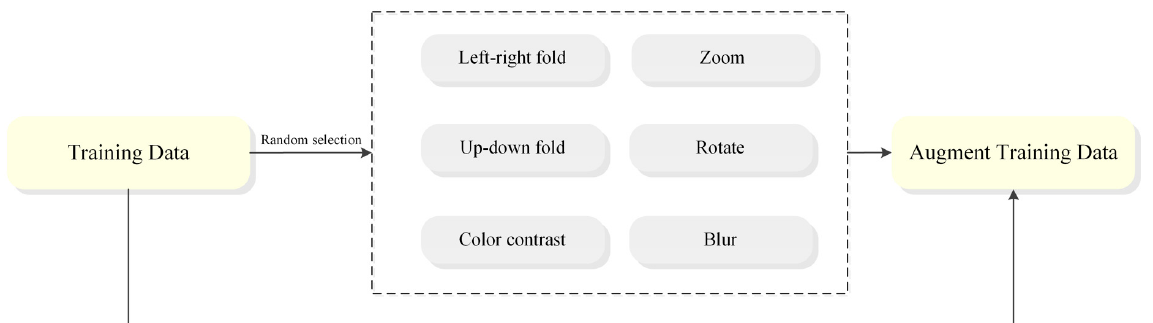
Figure 2. Image increment method for the training dataset.